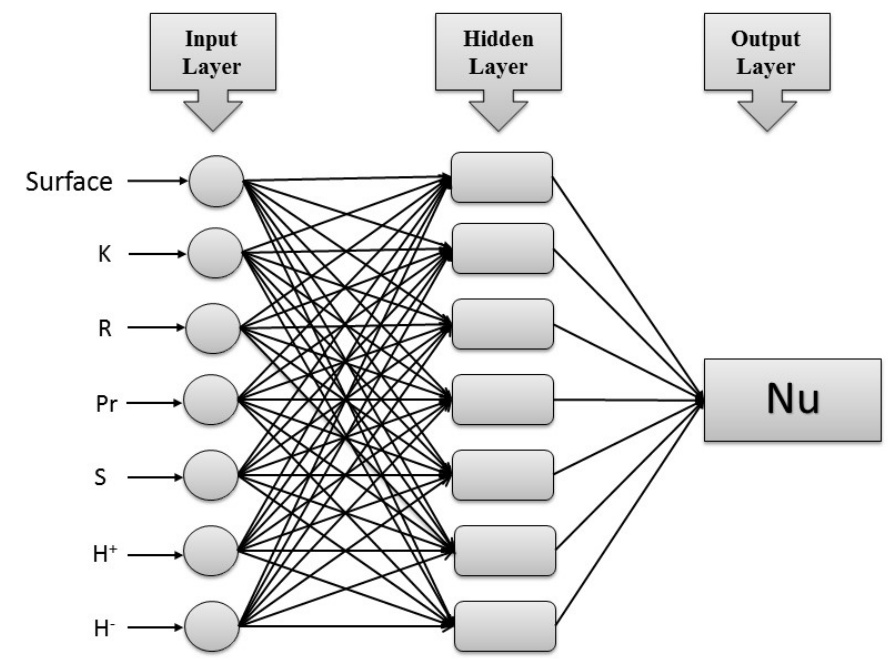
Figure 3. An MLP network model’s symbolic architecture.